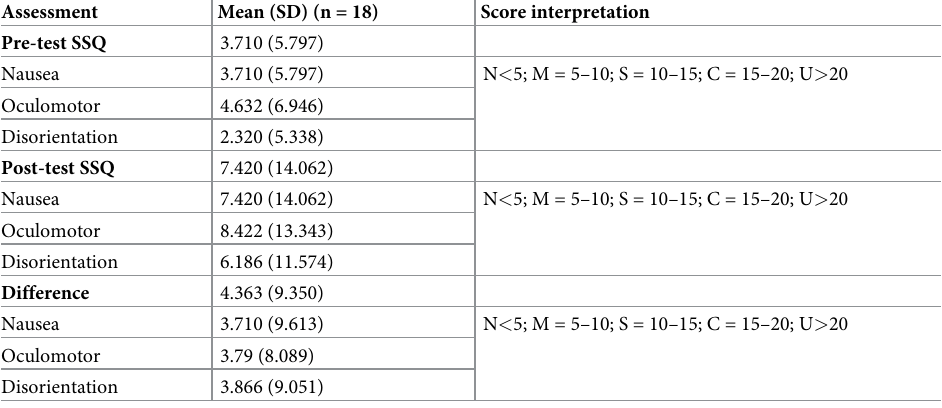
Table 3. Mean and standard deviation (SD) outcomes of Simulator Sickness Questionnarie (SSQ) Pre-experimen- tal test and post-experimental test, and differential values of elderly people. The interpretation of the mean scores for each subscale is provided in the form: N = negligible; M = minimal; S = significant; C = concerning; U =